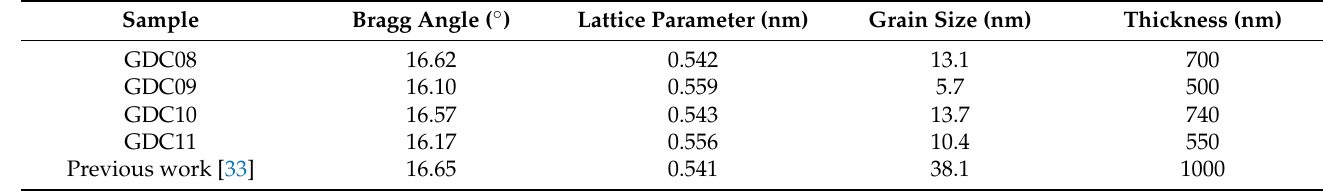
Figure 2. EDS spectra of GDC films deposited by the arc cathodic technique. Table 2. Lattice parameter, grain size, and thickness for each sample.